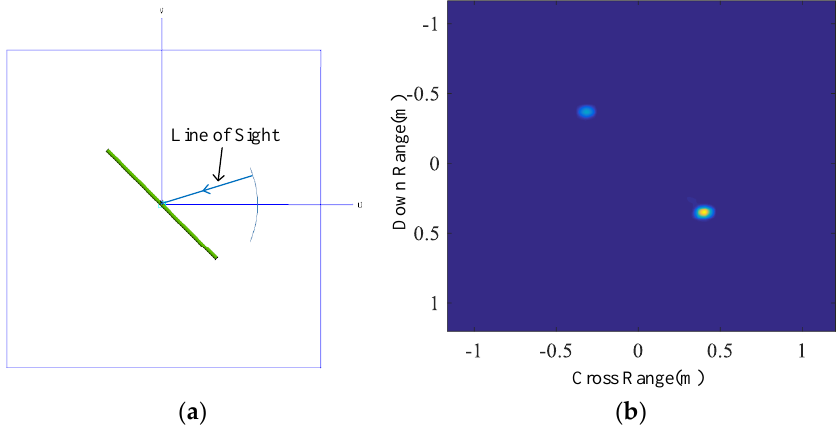
Figure 3. The imaging result of a metal rod under the condition that the incident direction is not vertical to the flank during the acquisition. ( a ) Imaging scene. ( b ) SAR imaging result.